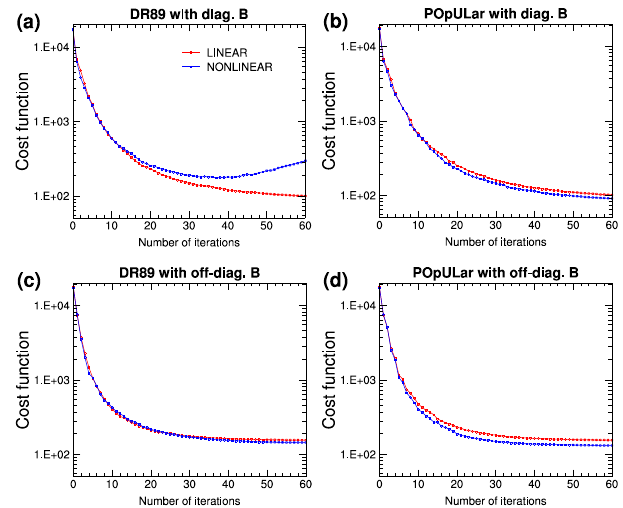
Figure 3. Cost function changes with iterations for the linear (red) and nonlinear (blue) models. Sensitivities to the optimization schemes (DR89: left; POpULar: right) and to the prior error covari- ance matrixes (diagonal: upper; off-diagonal: bottom) are